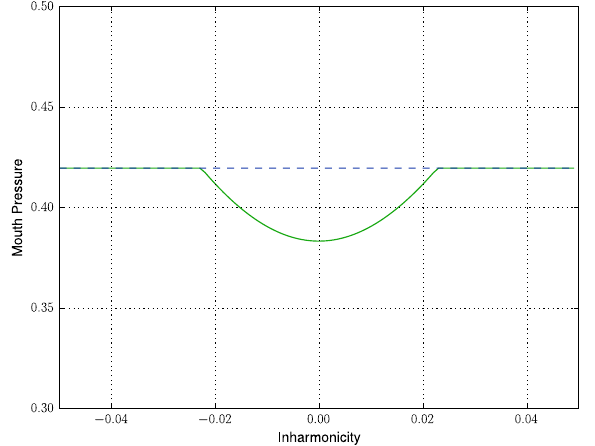
Figure 4. Minimum value of the mouth pressure c (green line) corresponding to a stable periodic solution (fundamental regime) with respect to the inharmonicity Inh (case Z 1 > Z 2 ; in practice Z 1 / Z 2 = 3/2). Linear threshold c thr1 (blue dashed line).